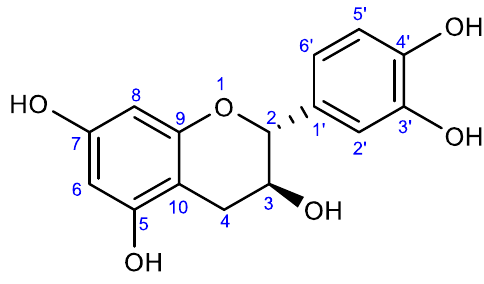
Figure 1. Molecular structure of catechin.